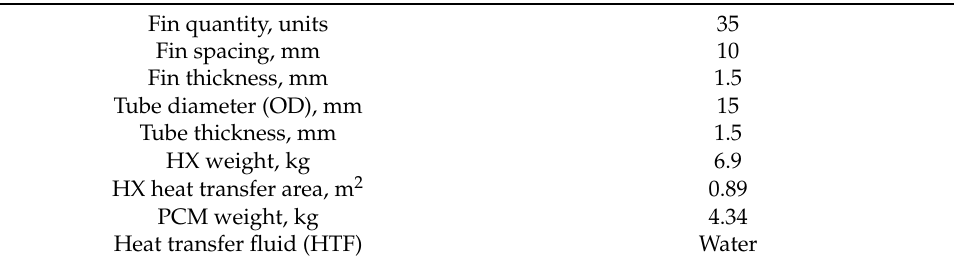
Figure 2. Positions of the temperature sensors. Table 1. Parameters of analyzed PCM Table 1. Parameters of analyzed PCM TES.